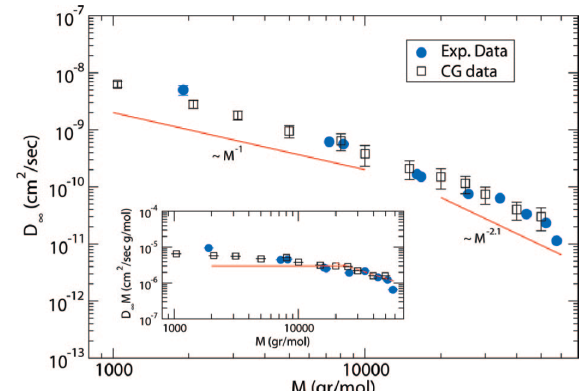
Figure 5. Self-diffusion coefficient of PS melts at T = 463 K [93], after correcting for the chain length dependent friction coefficient, D ∞ M , as a function of the molecular weight. In the inset D ∞ M vs M is shown at T = 463 K [93]. Experimental data are corrected for the different temperature ( T = 458 K) with the temperature dependence reported in Reference [46]. Reprinted from [93] with permission from